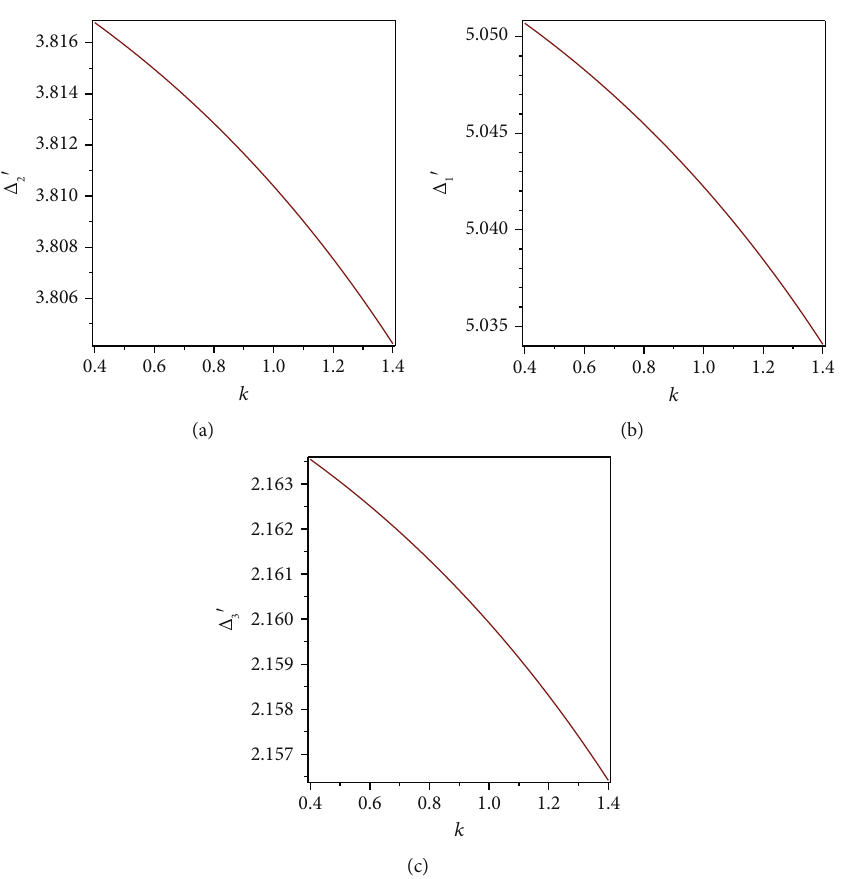
= 0 : 5 (a), for the medium 1